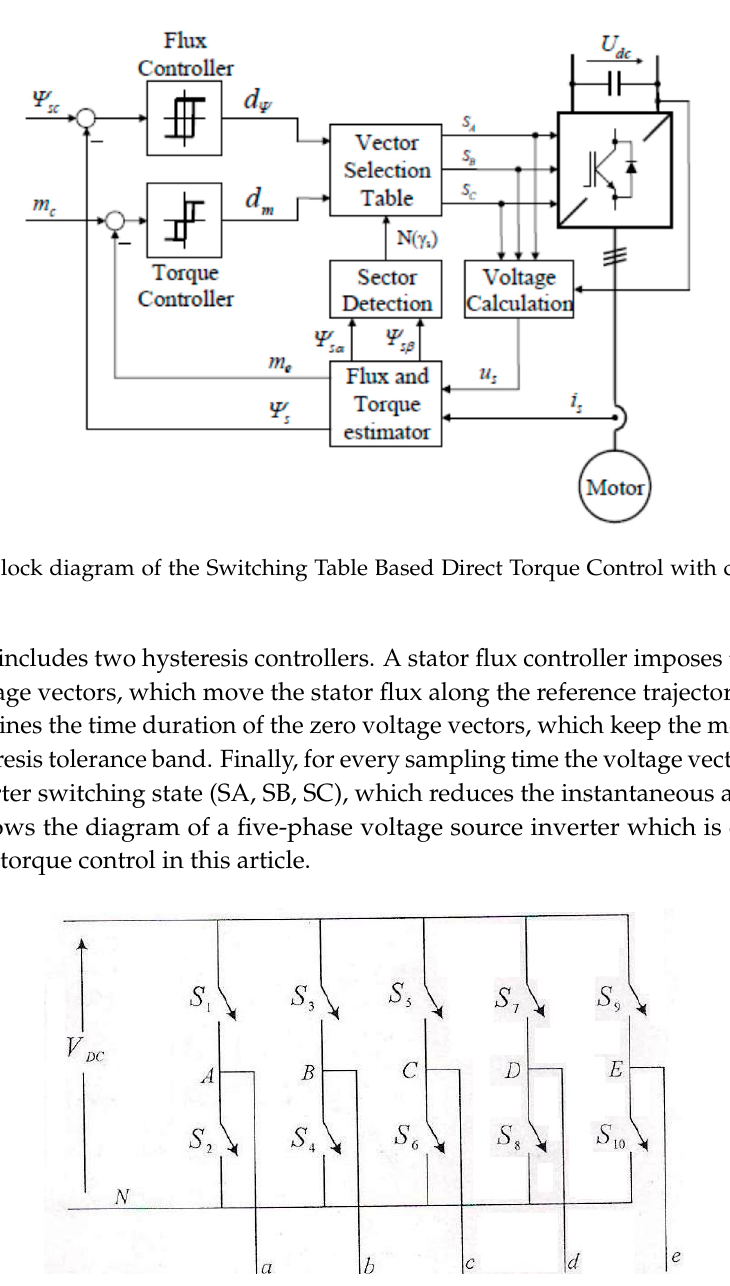
Figure 2 . Diagram of a five-phase voltage source inverter.